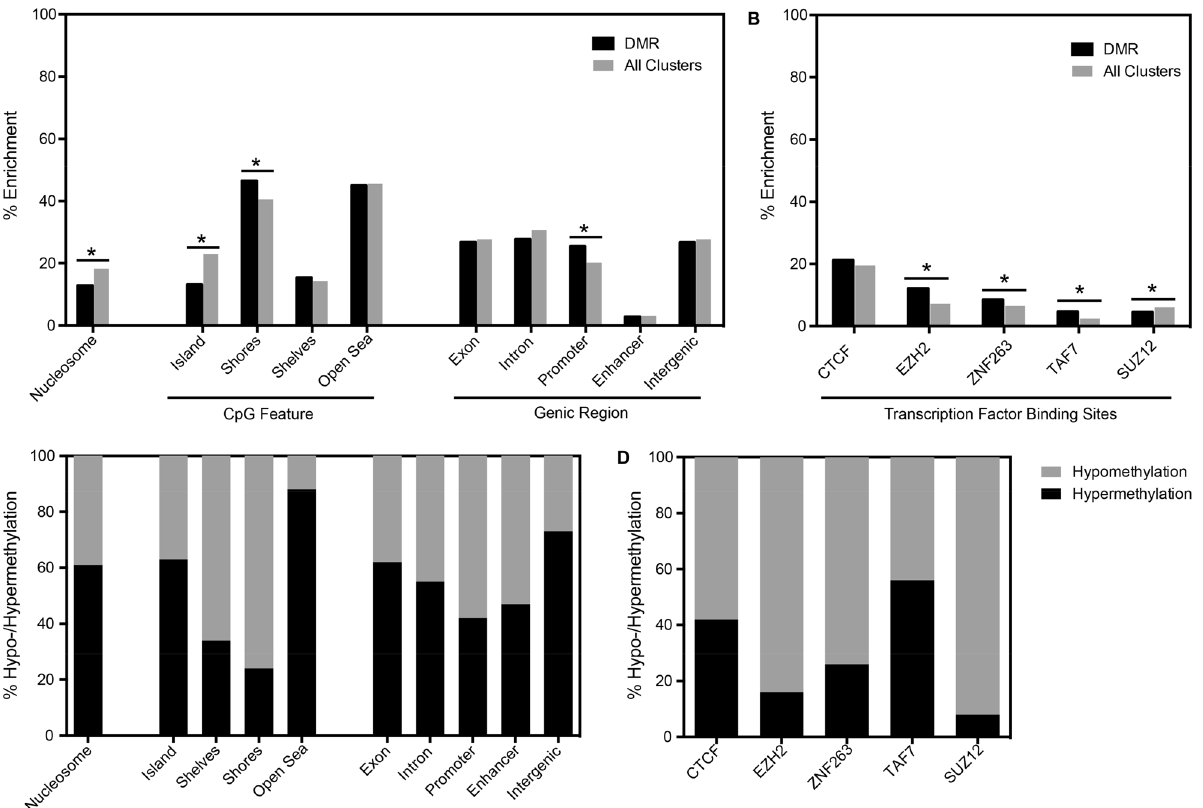
Figure 3. Localization of age-associated sperm DMRs. Enrichment analysis of all methylation clusters compared to DMRs at ( A ) nucleosome, CpG feature, and genic regions and ( B ) transcription factor binding sites and ( C , D ) their respective age-associated methylation patterns ( C , D ). Categories not exclusive, numbers may not add up to